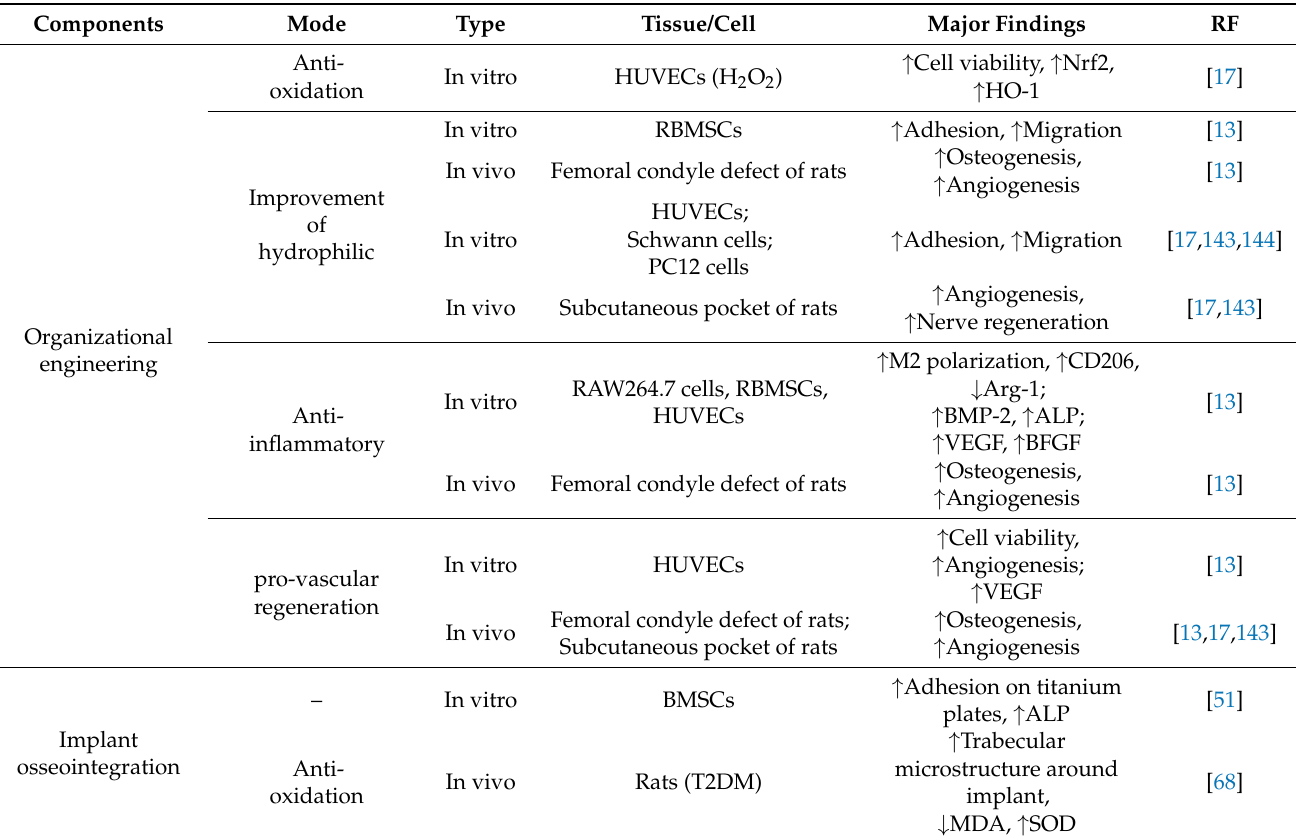
Table 2. Summarized effects of gastrodin on organizational engineering and osseointegration in vivo and in vitro